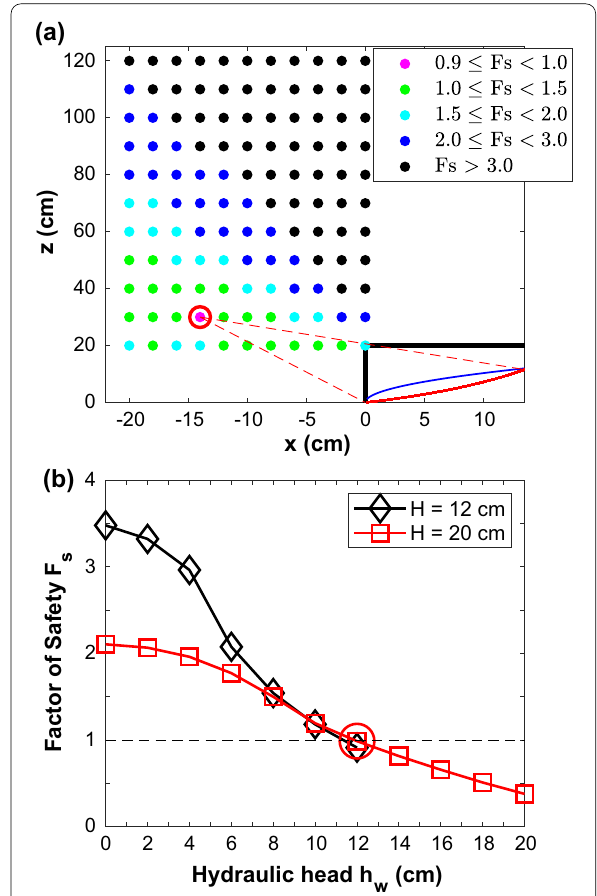
Fig. 14 a An example of a factor of safety F s calculation in which the center of slip circle (C) is varied. A black rectangle indicates the cliff ( H = 20 cm, L = 13.5 cm). A blue curve indicates the phreatic surface with a hydraulic head h w = 12 cm at x = 13.5 cm. Filled circles indicate the C, and their colors represent the calculated F s (see legend for their values). A red circle indicates the C at which the F s is the minimum ( F s = 0.99 ). Broken red lines are the slip circle radii, and a red arc is the slip circle sector. b F s versus h w calculated for cliffs with 2 different H values (see legend). For each H , the h w is varied in the range of h w ≤ H . A red (cid:31) corresponds to the minimum F s in